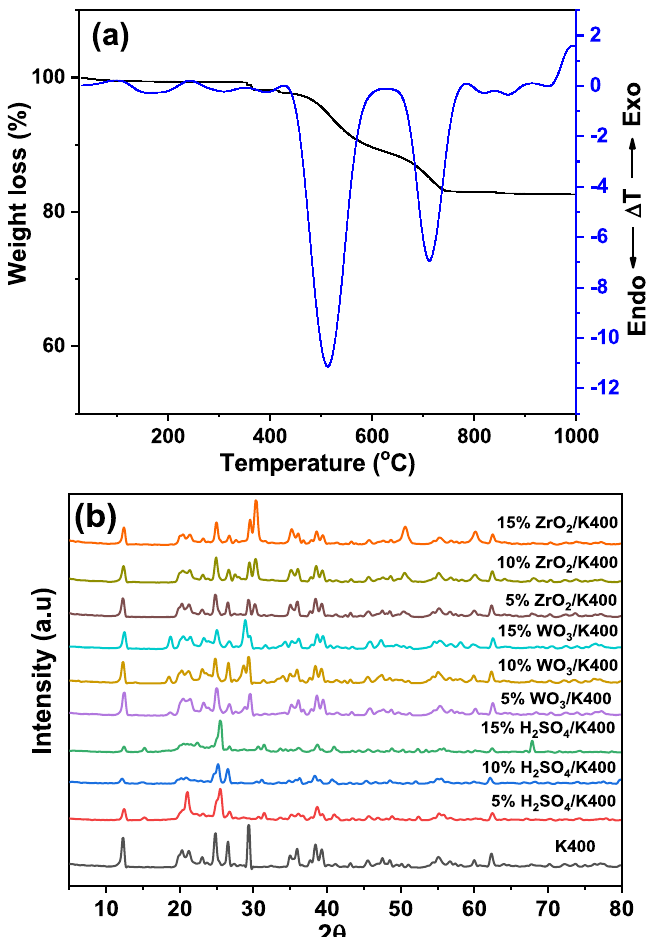
Figure 1. ( a ) TG and DTA curves of raw Kaolin and ( b ) XRD diffraction patterns of kaolin and modified kaolin catalysts calcined at 400 °C.